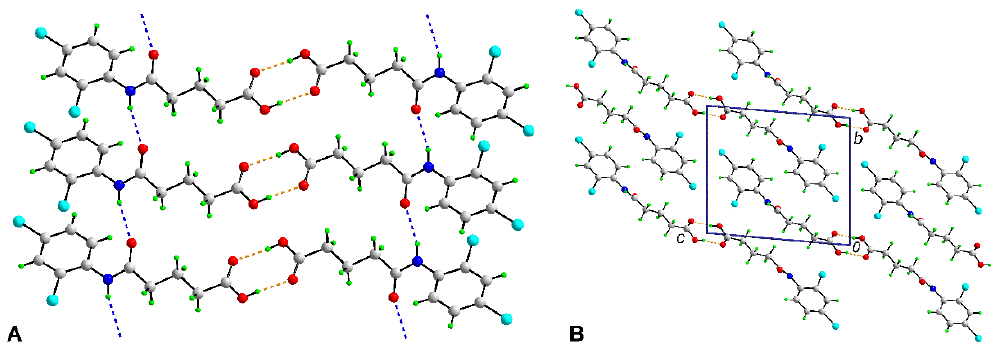
Figure 4. Molecular packing in the crystal of ( 1 ): ( A ) a view of the supramolecular tape featuring O–H ... O and N–H ... O hydrogen bonding shown as orange and blue dashed lines, respectively, and ( B ) a view of the unit-cell contents shown in projection down the a -axis. Selected intermolecular parameters: O2–H2o ... O1 i : [H2o ... O1 i = 1.84(3) Å, O2 ... O1 i = 2.653(3) Å and angle at H2o = 170(4)° for symmetry operation (i) 1 − x , − y , − z ], N1–H1n ... O3 ii [H1n ... O3 ii = 2.125(17) Å, N1 ... O3 ii = 2.952(2) Å, and angle at H1n = 163(3)° for (ii) 1 + x , y , z ].